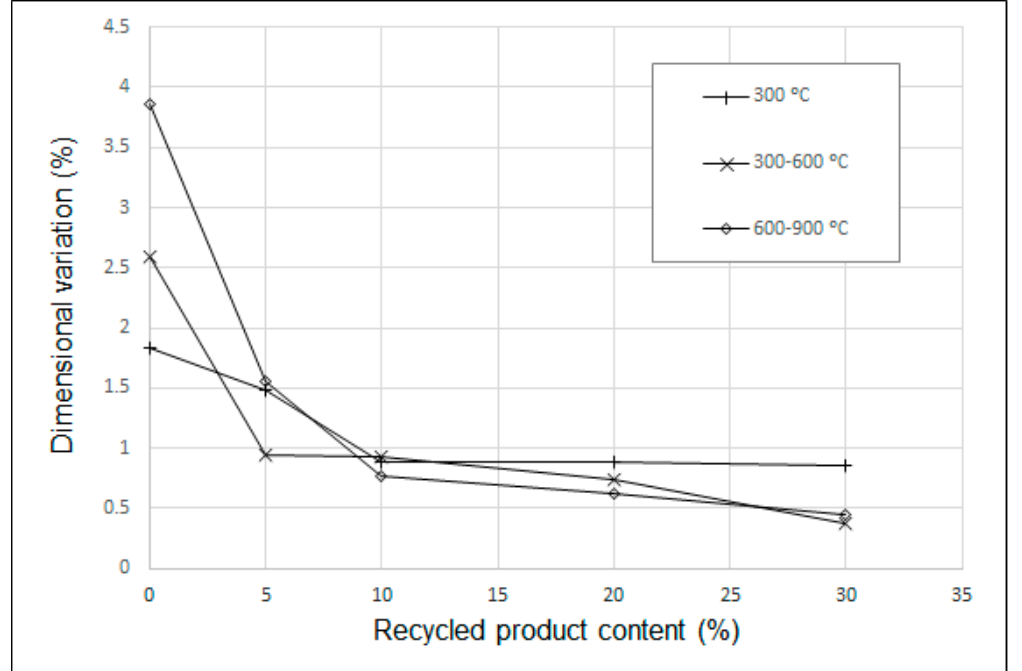
◦ C, 300–600 ◦ C, and 600–900 ◦ Figure 9. Dimensional variation at 300 °C, 300–600 °C, and 600–900 °C. Figure 9. Dimensional variation at 300 °C, 300–600 °C, and 600–900 °C. Figure 9. Dimensional variation at 300